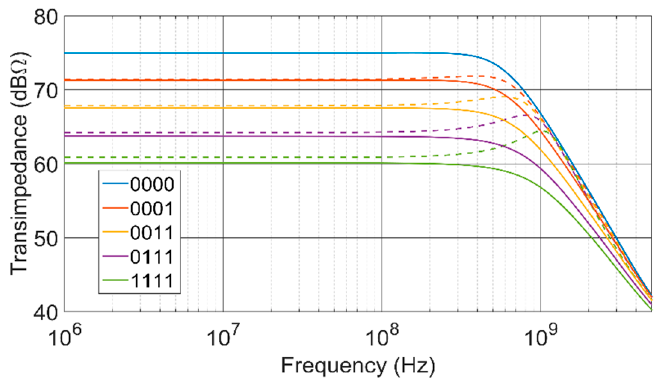
Figure 5. Frequency response of the TIA with simultaneous gain control (solid line) and single feedback resistor control (dashed line).